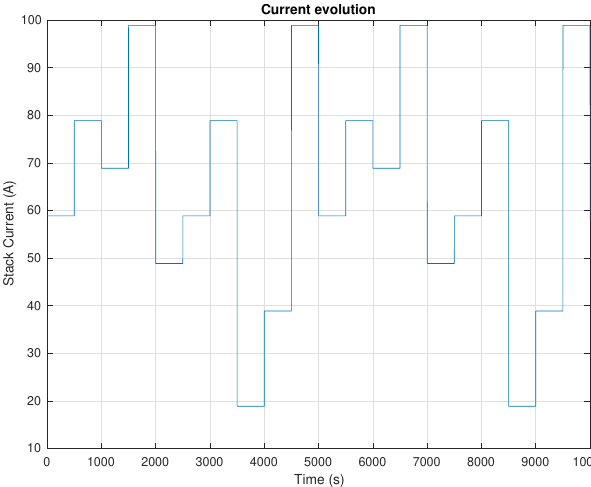
Figure 24. Current profile during the